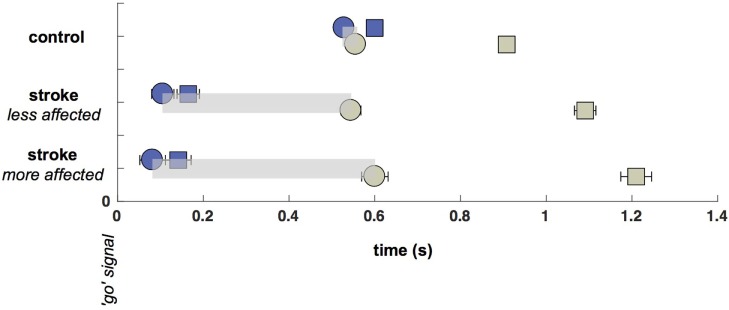
Saccade and Reach Latencies (onsets: circles, terminations: squares). Saccade onsets (blue circles) occur substantially earlier in the stroke cohort, although reach onsets (green circles) are nearly the same across participants regardless of cohort or laterality (with a small delay on the more-affected side). Time between saccade and reach onsets is shown with a light gray bar.